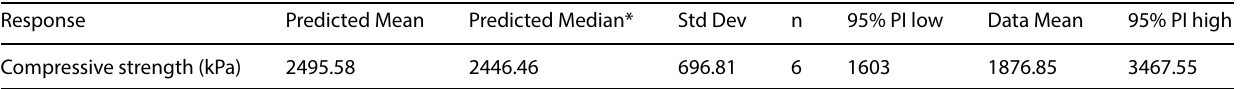
Table 5 Results of the validation runs at urea concentration 1492 mM, calcium chloride concentration 1391 mM and volume of cell suspen- sion 7.47 mL